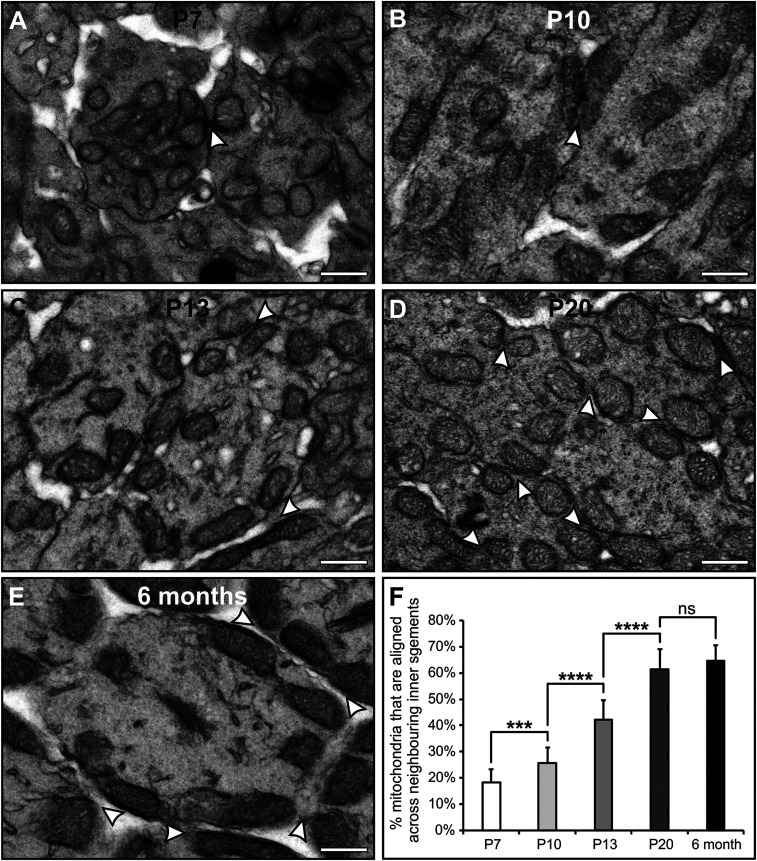
The mitochondria of neighboring ISs are not aligned until P20. (A–E) TEM images of ISs from mice of ages P7 (A), P10 (B), P13 (C), P20 (D), and 6 mo (E). (F) There is increasing alignment of mitochondria between neighboring ISs up to P20 (average = 15 regions with ≥158 mitochondria from three eyes). White arrowheads indicate alignment of neighboring IS mitochondria. (Scale bars: 500 nm). ***P < 0.001; ****P < 0.0001; ns, not significant (determined by Student's t-test).